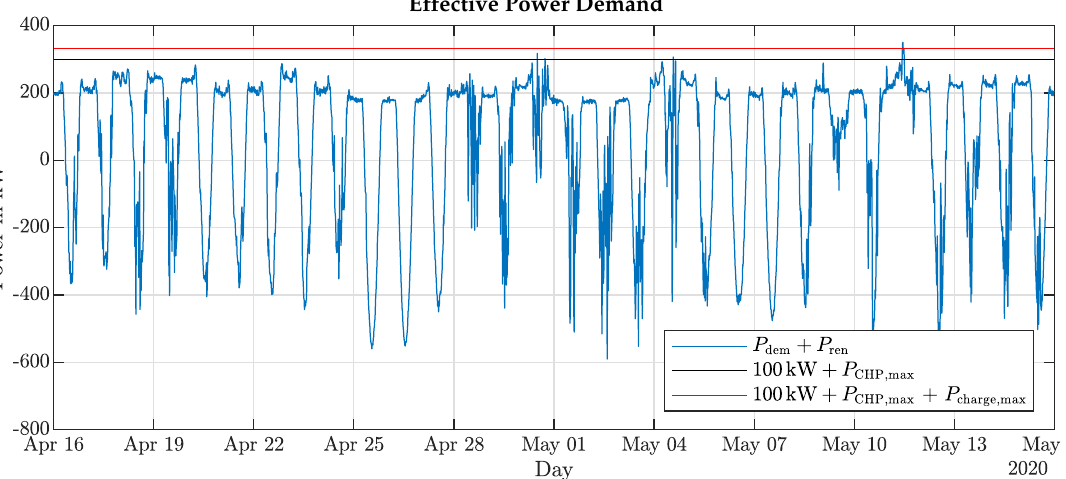
Figure 2. Effective power demand, i.e., building consumption and PV production summed for the simulated time horizon. The black line shows the limit above which the CHP is insufficient to maintain a peak of 100 kW. The red line shows the limit if the battery is discharged at its maximum, i.e., the theoretic demand limit for which the initial peak of 100 kW could be held. On 11 May, a minimum peak of P grid ≥ 118 kW is unavoidable, even if the CHP and the battery are employed at their